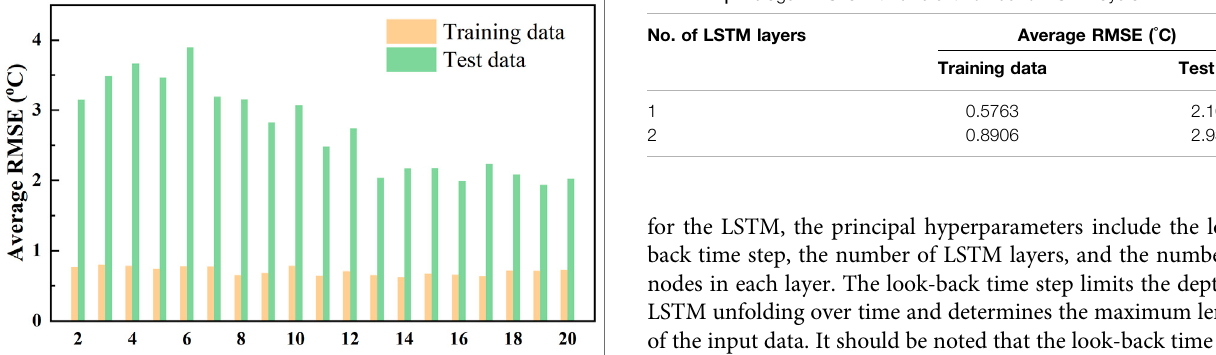
TABLE 2 | Average RMSEs with different number of LSTM